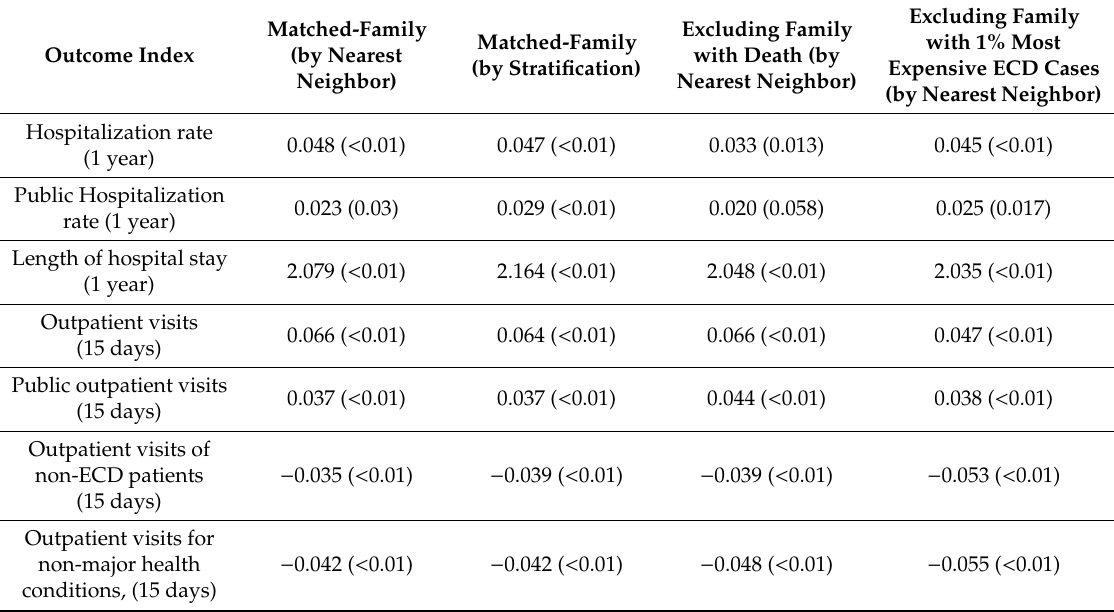
Table 3. Robustness check-e ff ects of ECD on health service utilization in China. (Unit: per family